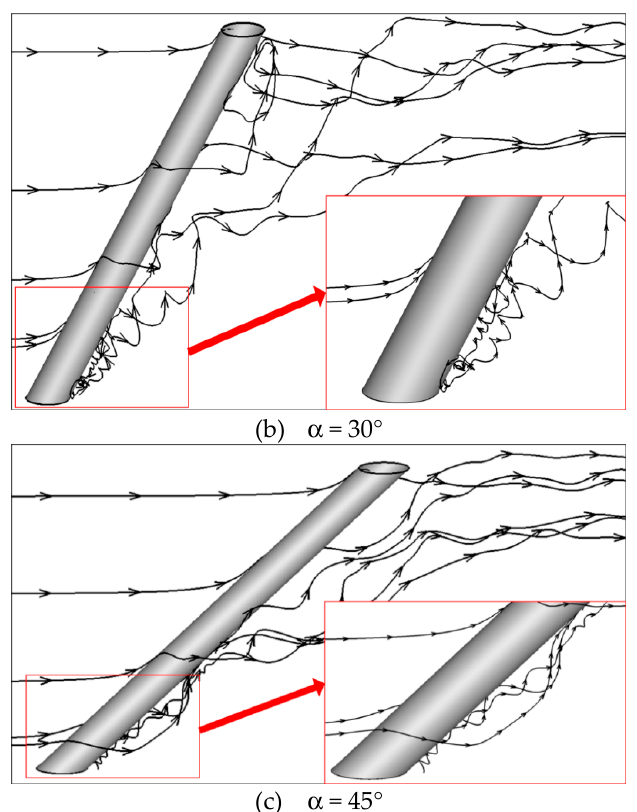
Figure 8. Streamline development for three yaw angles under nonslip boundary condition.